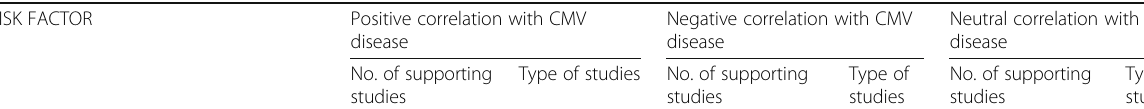
Table 2 Risk factors associated with CMV disease in the SLE population (2 studies) RISK FACTOR Positive correlation with CMV